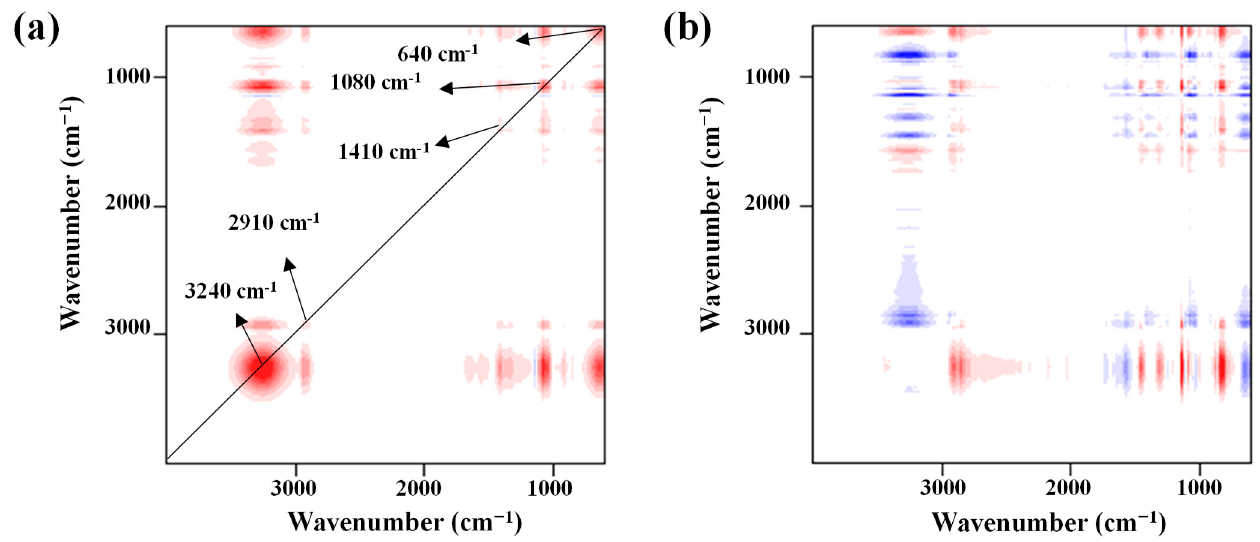
Figure 4. 2DCOS analysis diagram of PVA/NCD-TiO 2 . ( a ) Synchronous spectral analysis and ( b ) asynchronous spectral analysis.